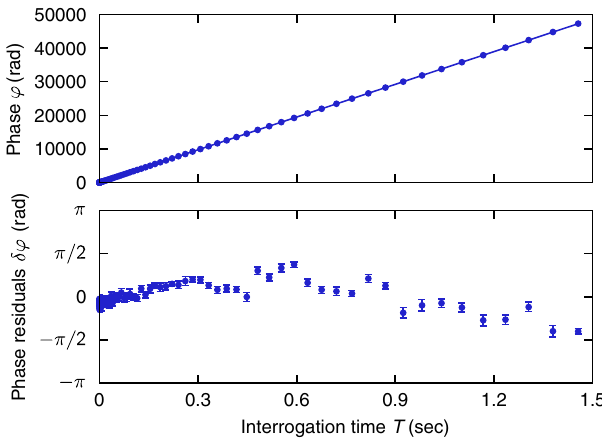
FIG. 2. Incremental measurement of the phase accumulation rate Δ ω at an ion distance of d ¼ 6 . 2 mm. A linear fit to measurements of the accumulated phase φ at predefined inter- rogation times (top part), and the fit residuals δφ for each phase measurement are shown (bottom part). For each point, measure- ments of both operators have been repeated 50